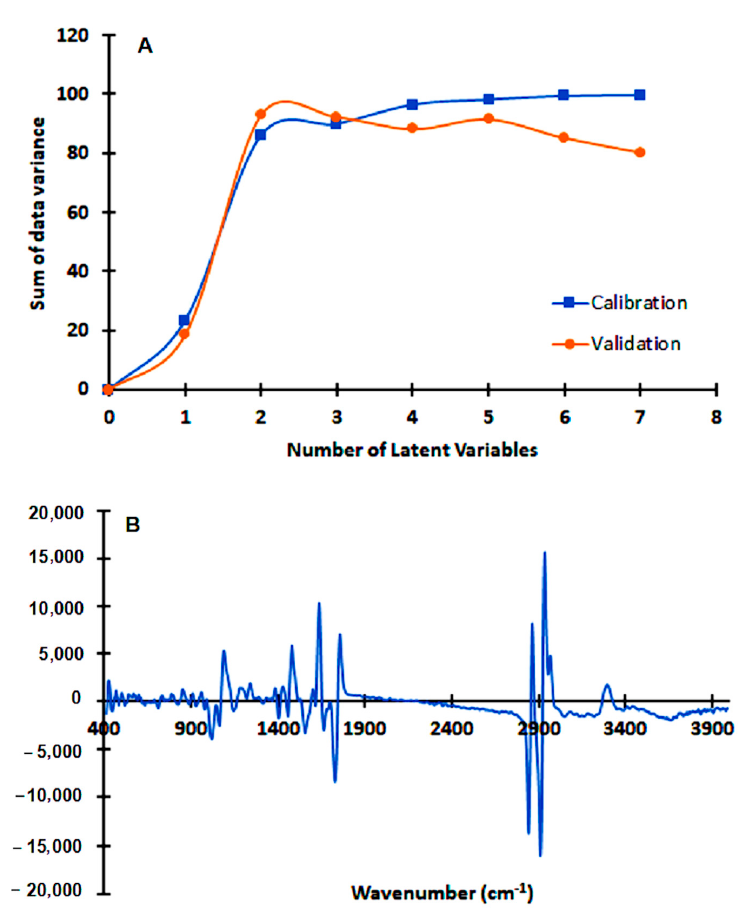
Figure 4. A partial least square (PLS) regression model based on bacteria spectra of experiment 4 (Table 1). Spectra were pre-processed by o ff -set, MSC, and first derivative. ( A ) The sum of data variance along with latent variables; ( B ) Regression vector with three latent